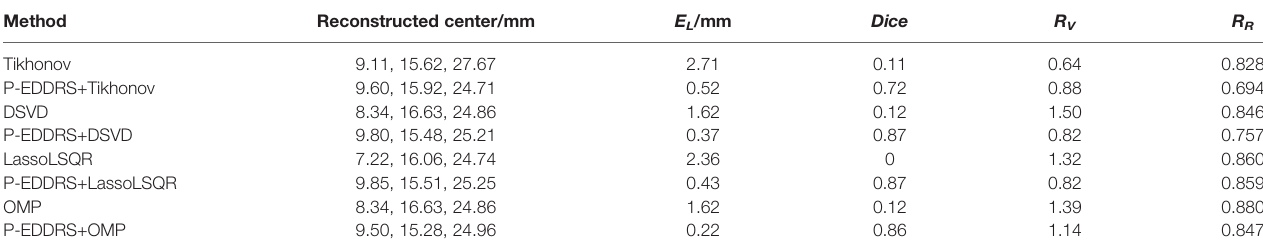
TABLE 2 | Quantitative evaluation results of P-EDDRS framework feasibility veri fi cation in CLT.